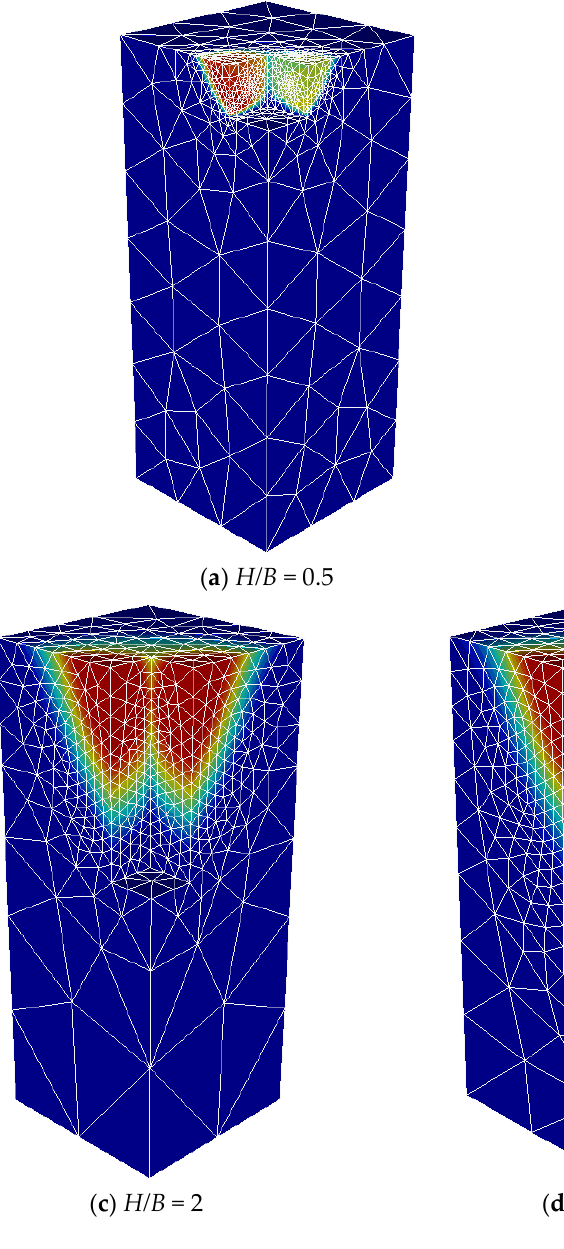
Figure 6. Potential failure mechanisms—effect of H/B ( r e = 0.7, m = 4, and B/L = 1).